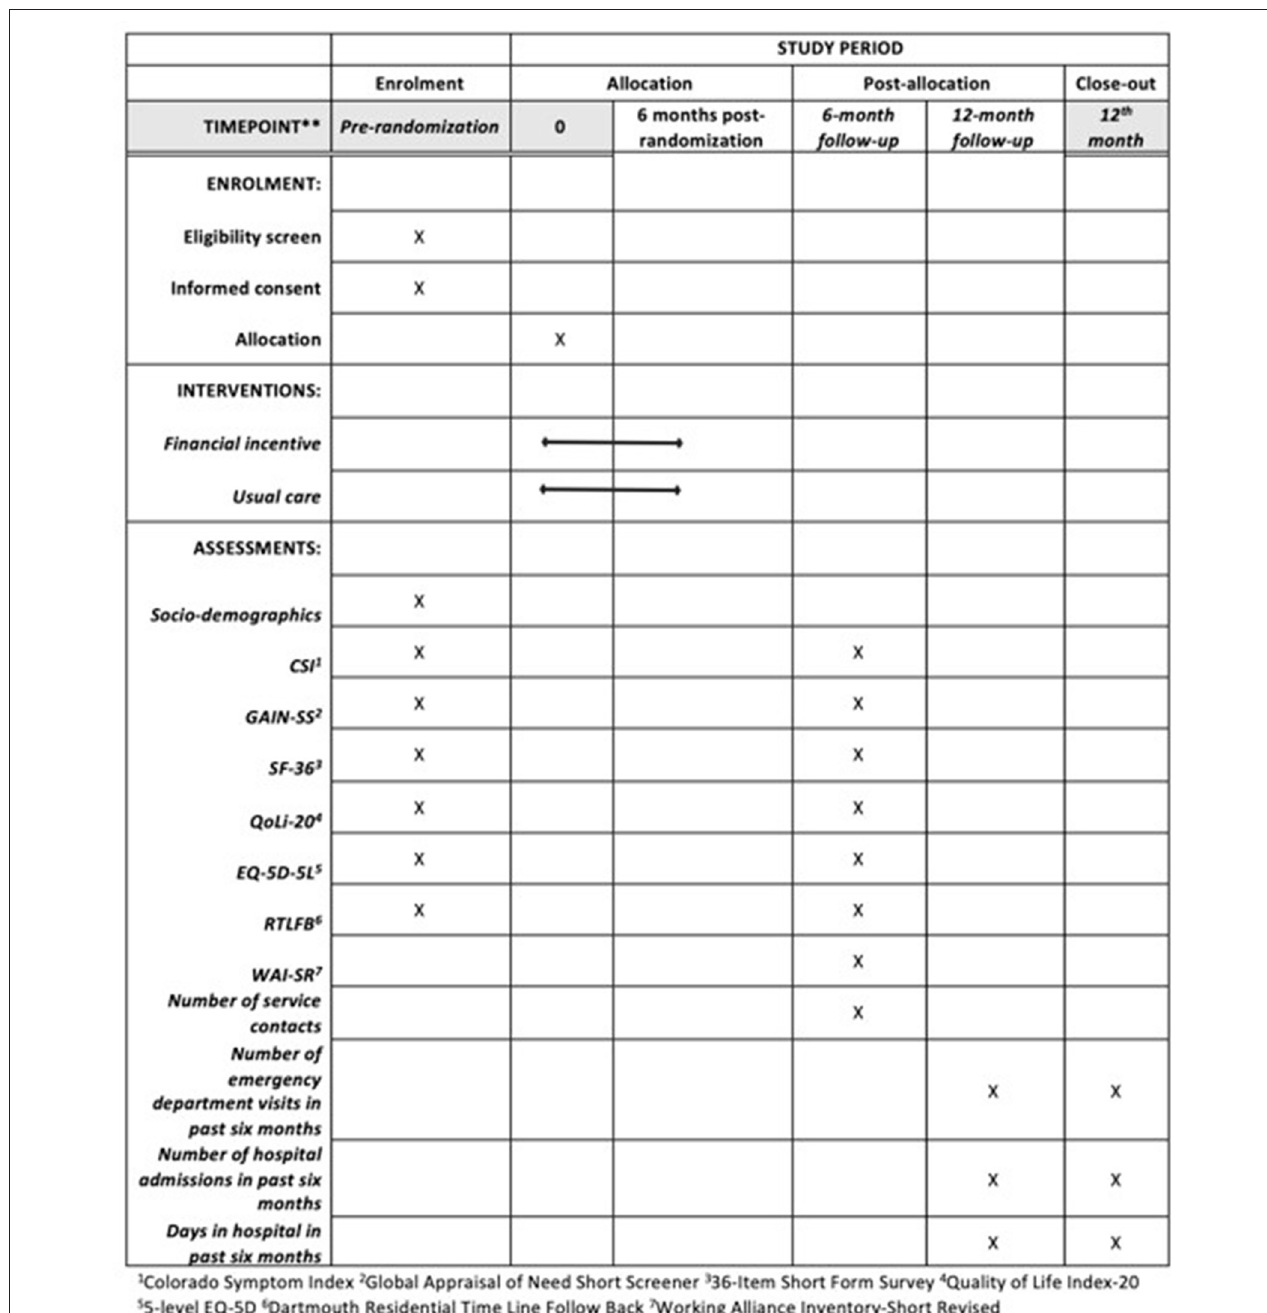
FIGURE 1 | Schedule of enrolment, intervention, and